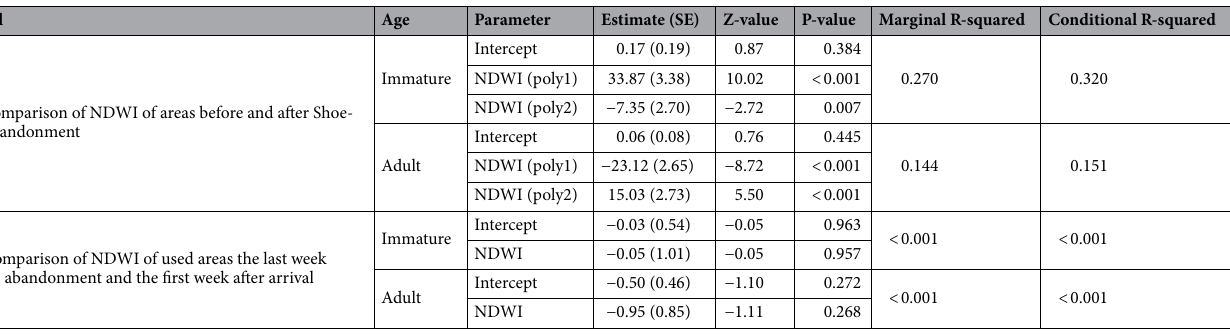
Table 3. Results of the GLMM models comparing the values of: (a) daily mean NDWI of Areas before Shoebill abandonment, with the values of NDWI after the birds abandoned the Area, using year and Area nested within bird ID as random effects. Daily mean NDWI was transformed as a second-degree polynomial (poly 1 and poly 2), (b) daily mean NDWI of used Areas the last week before abandonment, with the daily mean NDWI of used Areas the first week after arrival, using year and Area nested within bird ID as random